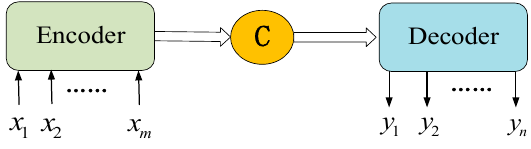
Figure 2. The structure of Seq2seq.